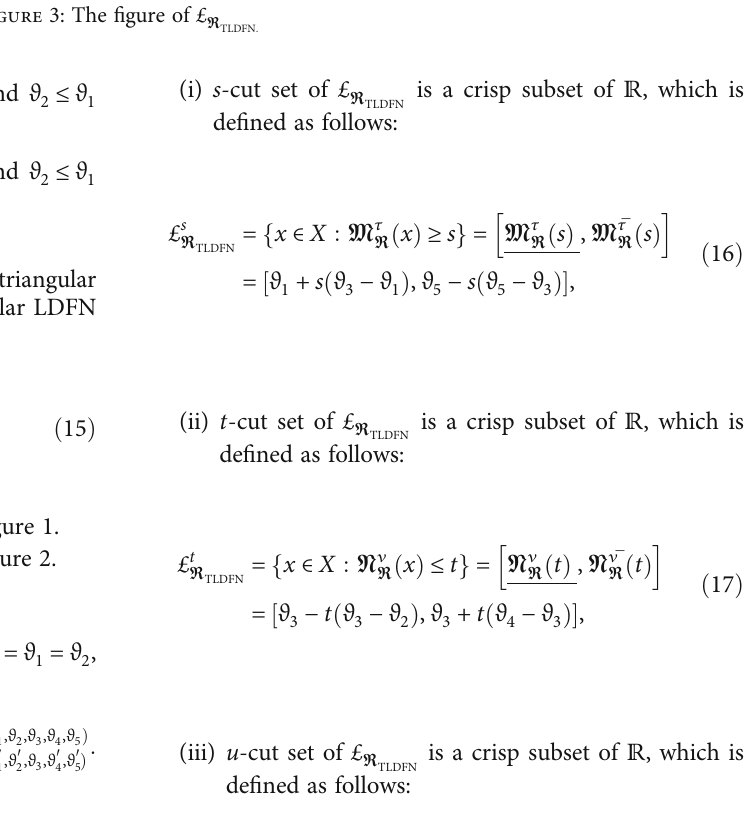
Figure 3: The fi gure of £